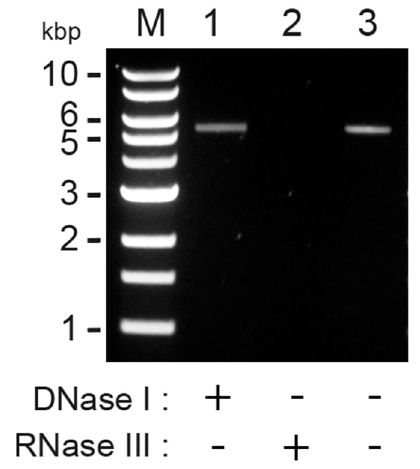
Figure 1. Extrachromosomal nucleic acids within P. membranifaciens are dsRNA molecules. Agarose gel electrophoresis of cellulose column-purified nucleic acids from P. membranifaciens NCYC333 (lane 3), treated with DNase I (lane 1) or ShortCut ® RNase III (lane 2). M indicates a DNA molecular weight marker, with the corresponding sizes labeled.